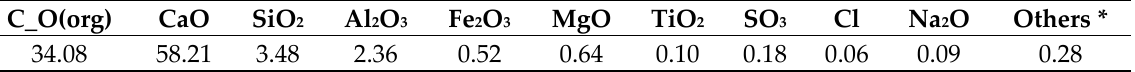
Table 1. Chemical composition of paper sludge waste (PSw).